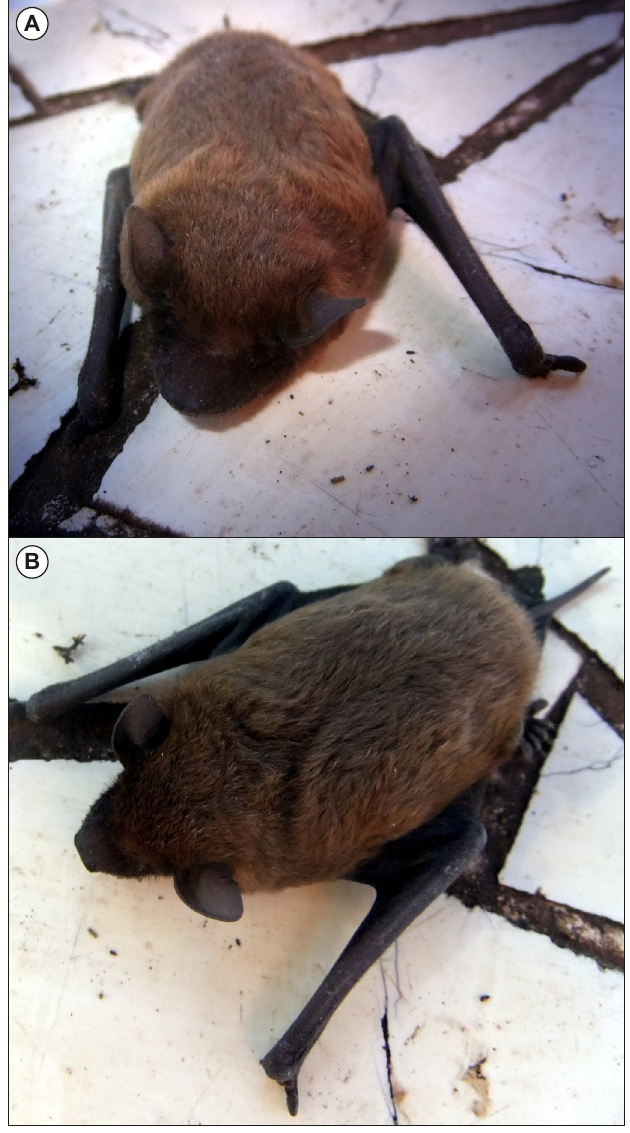
Figure 2. Frontal (a) and dorsal (b) view of the specimen